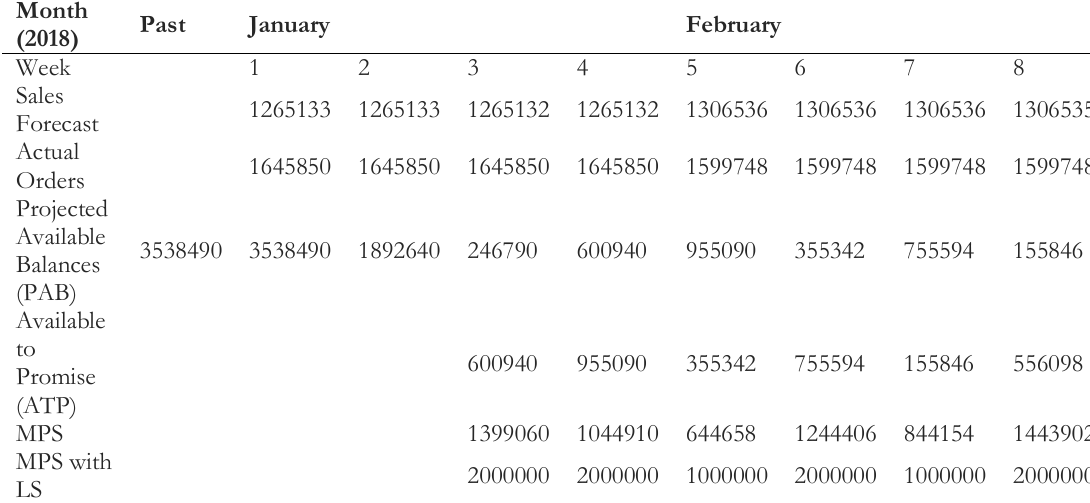
Table 6. MPS calculation for January and February.